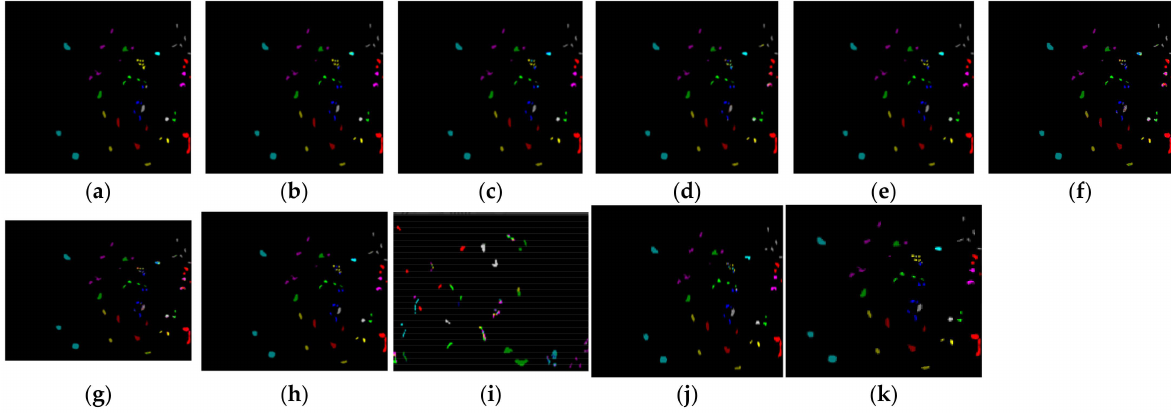
Figure 11. The overall accuracy and classification maps of different methods on the KSC dataset: ( a ) A2S2KResNe (91.22%); ( b ) DBDA (96.76%); ( c ) DBMA (94.12%); ( d ) PyResNet (91.49%); ( e ) SSRN (95.52%); ( f ) ViT (92.38%); ( g ) SVM (87.96%); ( h ) HybridSN (79.72%); ( i ) DCCNN (89.33%); ( j ) FDSSC (95.62%); ( k ) proposed